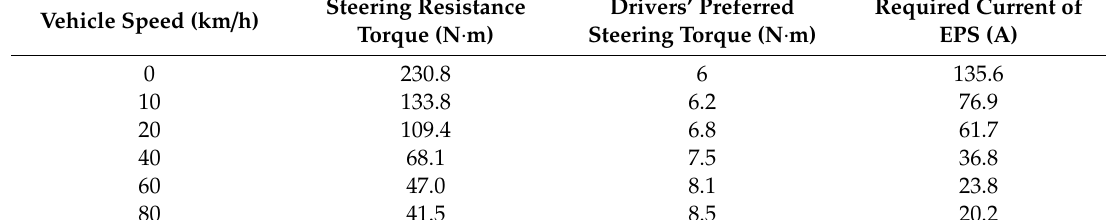
( b ) Figure 6. The collected signals in the test: ( a ) vehicle speed; ( b ) steering wheel torque.